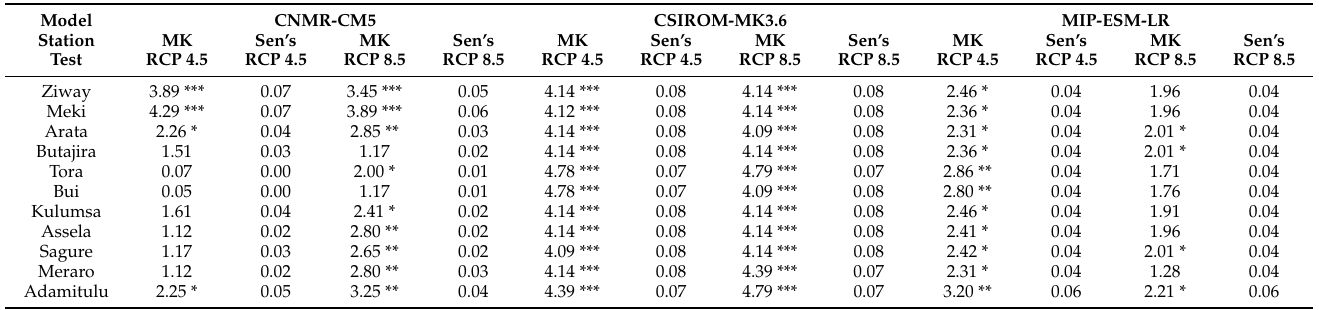
Table A10. Projected Mann–Kendall trend and Sen’s slope estimator results of annual mean T min for 11 stations over Ziway Lake Basin from the period 2026–2049.